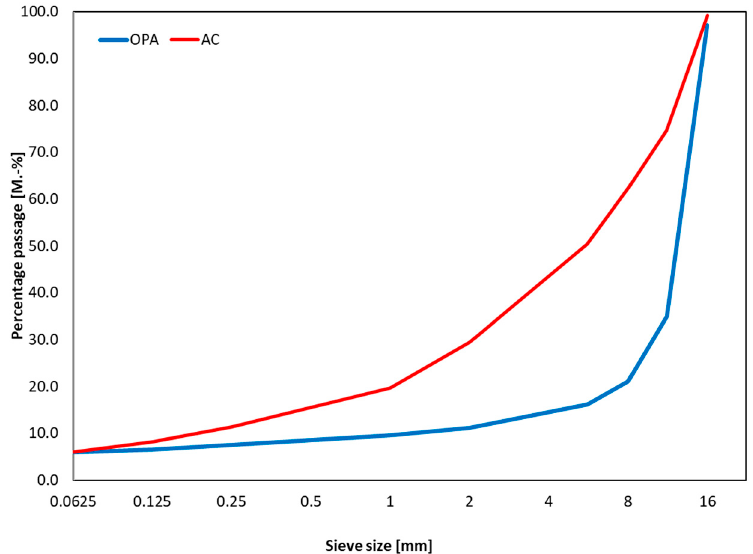
Figure 2. Aggregate gradation; asphalt concrete = red line; porous asphalt = blue line.